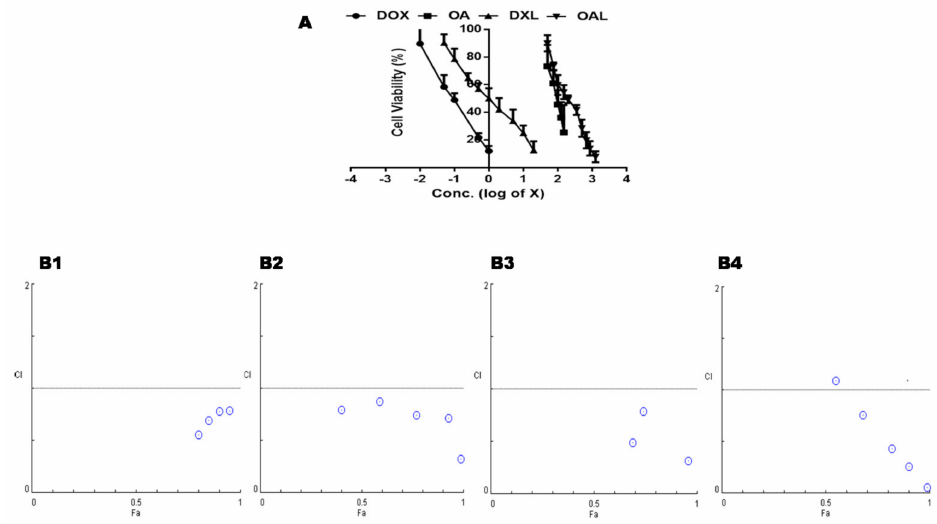
Figure 6. In Vitro antitumor effects on HepG2 cells after various drug treatments; free DOX, free OA, DOX loaded liposomes (DXL) and OA loaded liposome (OAL) ( A ) Concentration dependent gradual decrease in cell viability of HepG2 cells, ( B1 ) Combination indices at a fixed concentration of free OA (50 µ g/mL)with varying amount of free DOX, ( B2 ) Combination indices at a fixed concentration of free DOX (0.05 µ g/mL)with varying amount of free OA, ( B3 ) Combination indices at a fixed concentration of OA delivered through OA loaded liposome (OAL = 100 µ g/mL) against varying amount of DOX loaded liposome, ( B4 ) Combination indices at a fixed concentration of DOX delivered through DOX loaded liposome (DXL = 0.5 µ g/mL) against varying amount of OA loaded